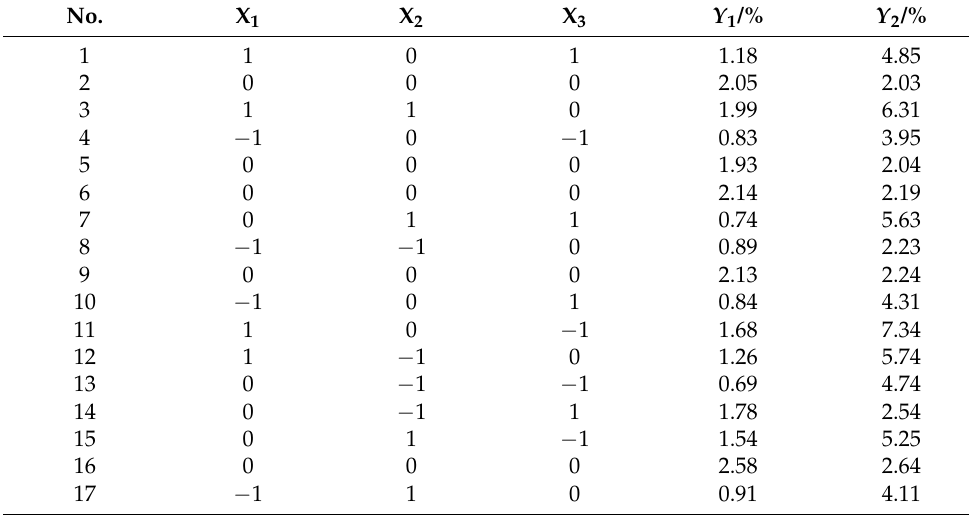
Table 5. Factors and levels of tests.